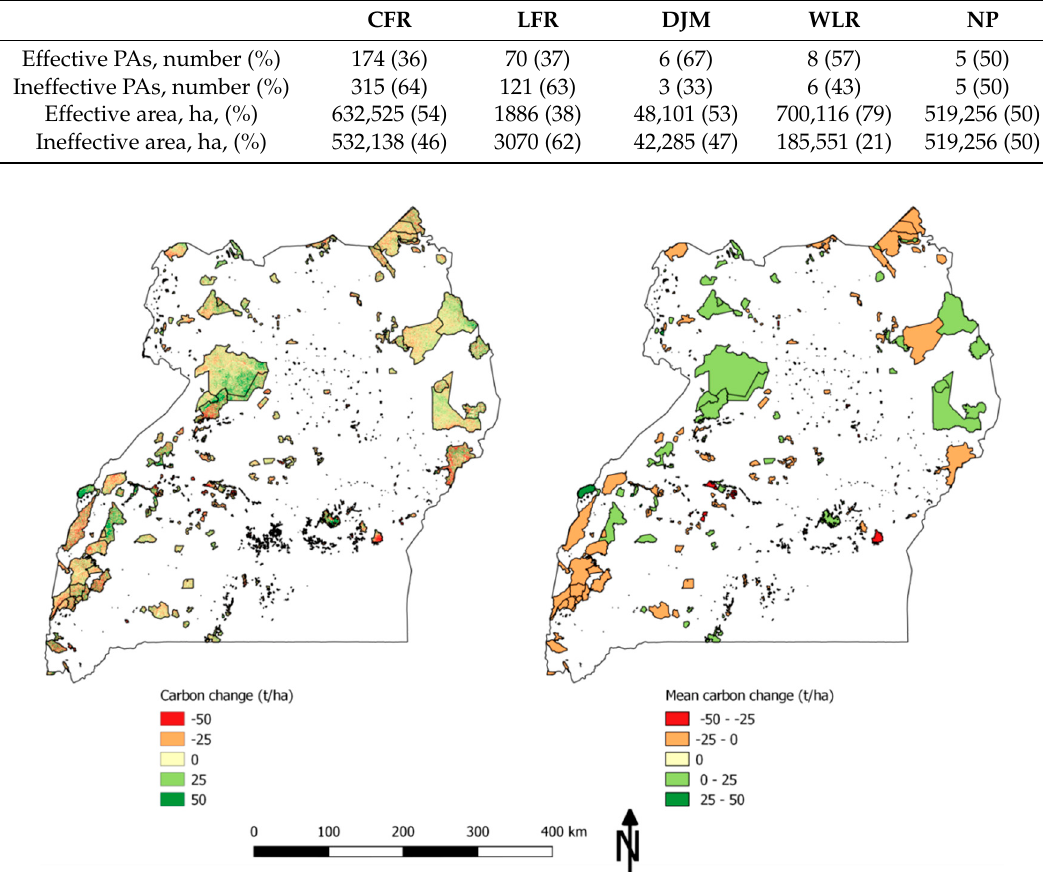
Figure 5. Carbon gain and loss range (green–red, respectively) in PAs of Uganda, ( left panel ). In the right panel , effective PAs (green), gained or maintained carbon; and ineffective PAs (orange and red), lost carbon during the period 2000–2012.